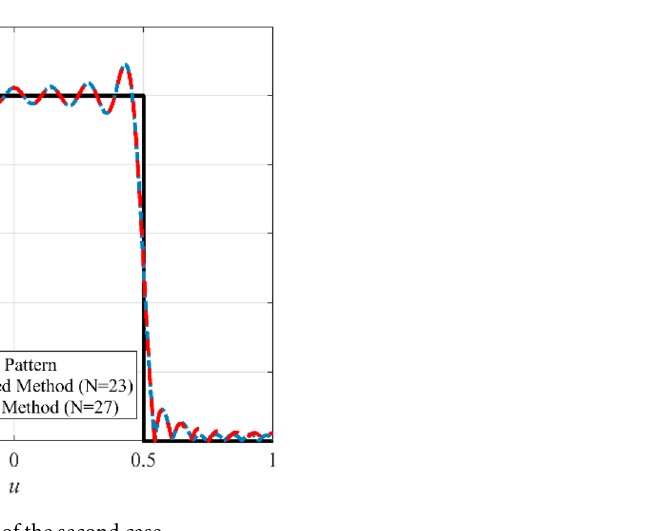
Figure 6. The synthesized results of the second